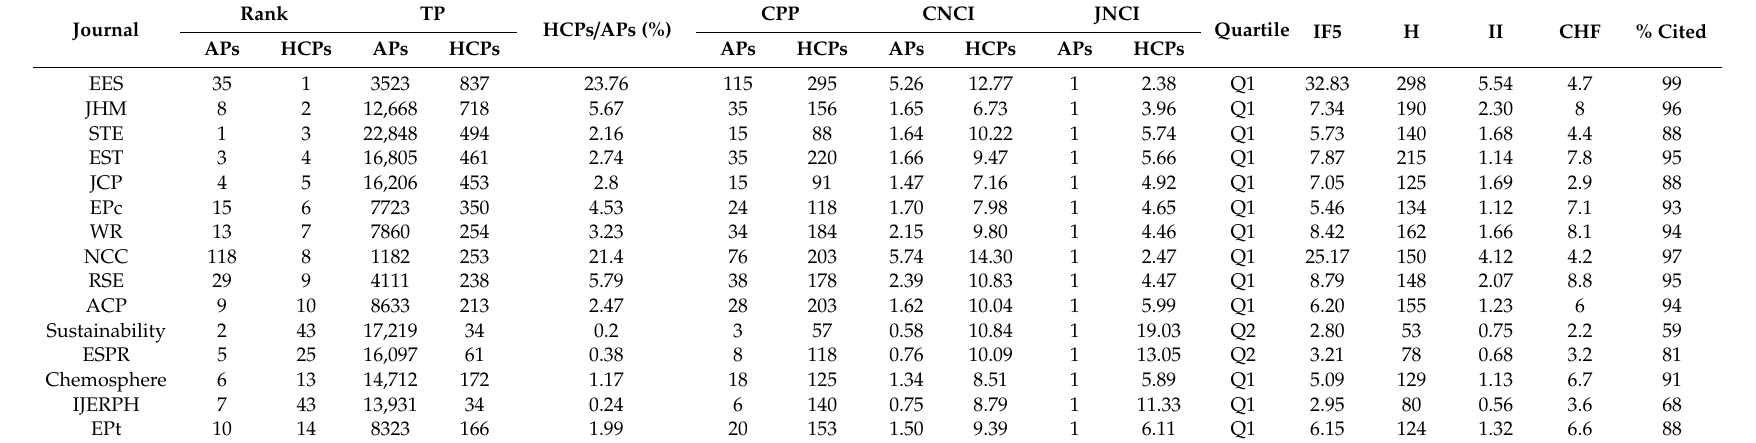
Table 1. Leading journals of HCPs and APs in the environmental sciences